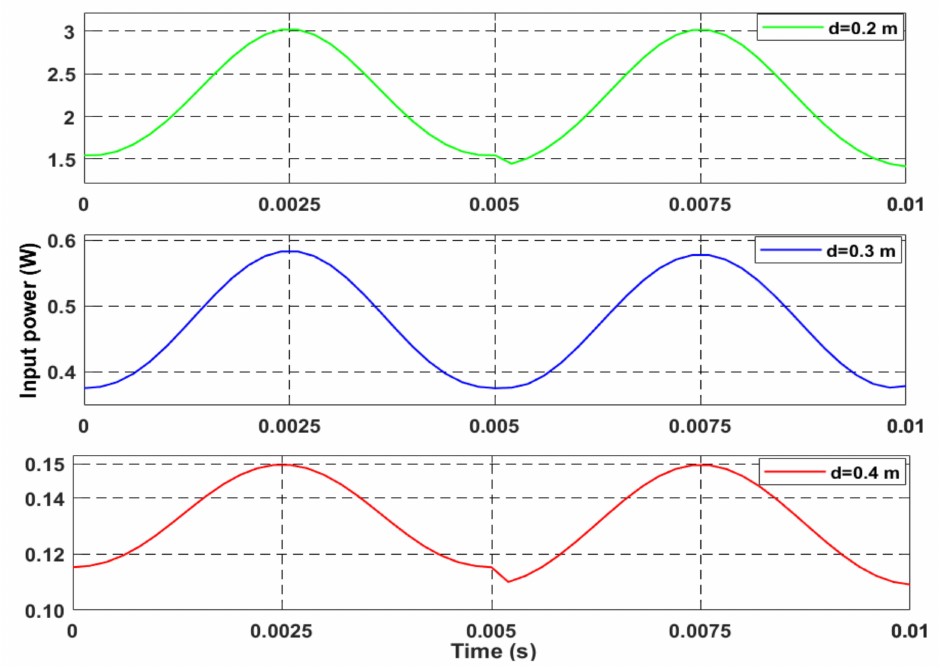
Figure 15. Maximum Input power variation with respect to time when θ ◦ ( t ) = α ◦ ( t ) and the distance d is varied from 0.2 m to 0.4 m.